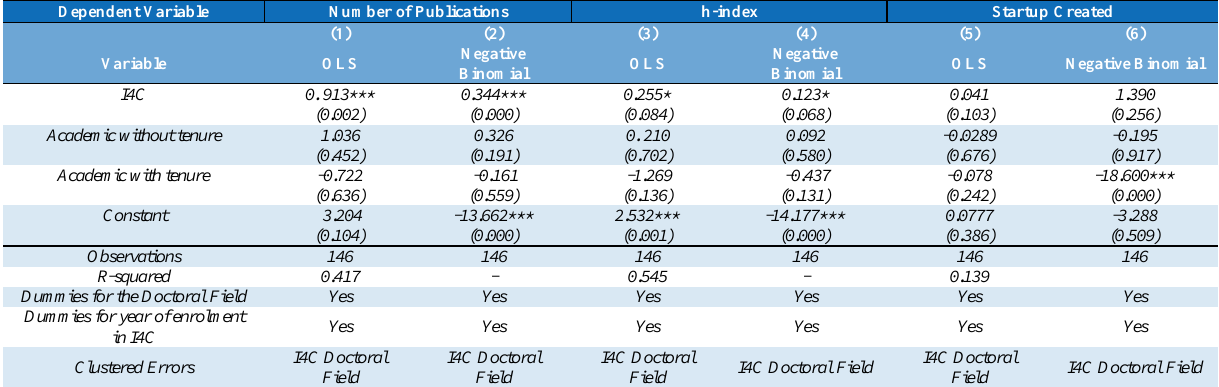
Tab. 5. Regression analysis on the